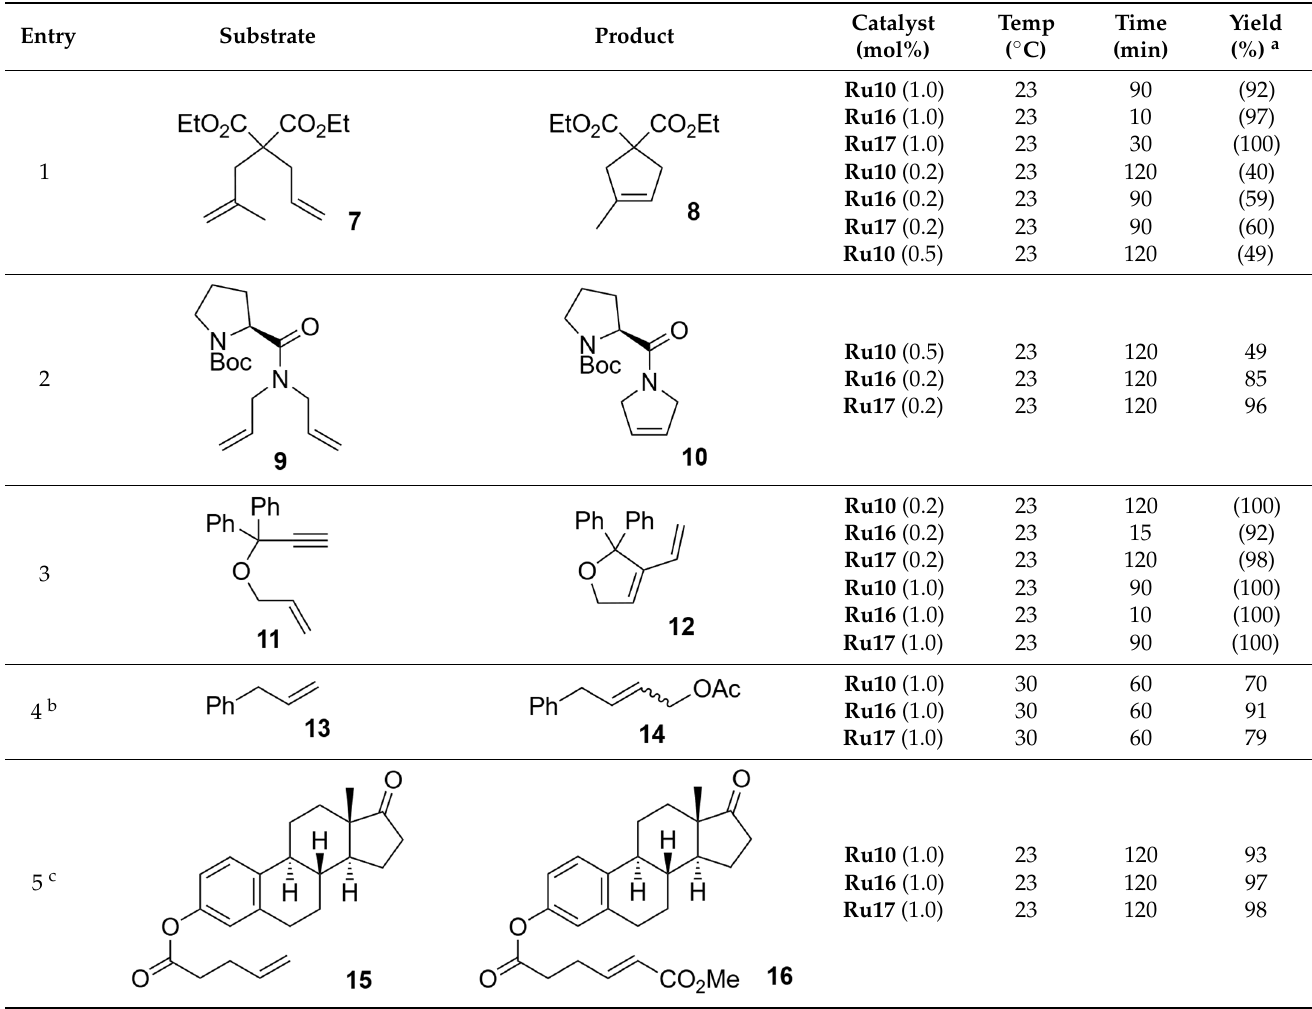
Table 1. Catalytical activity of Ru16 and Ru17 in comparison with Ru10 .